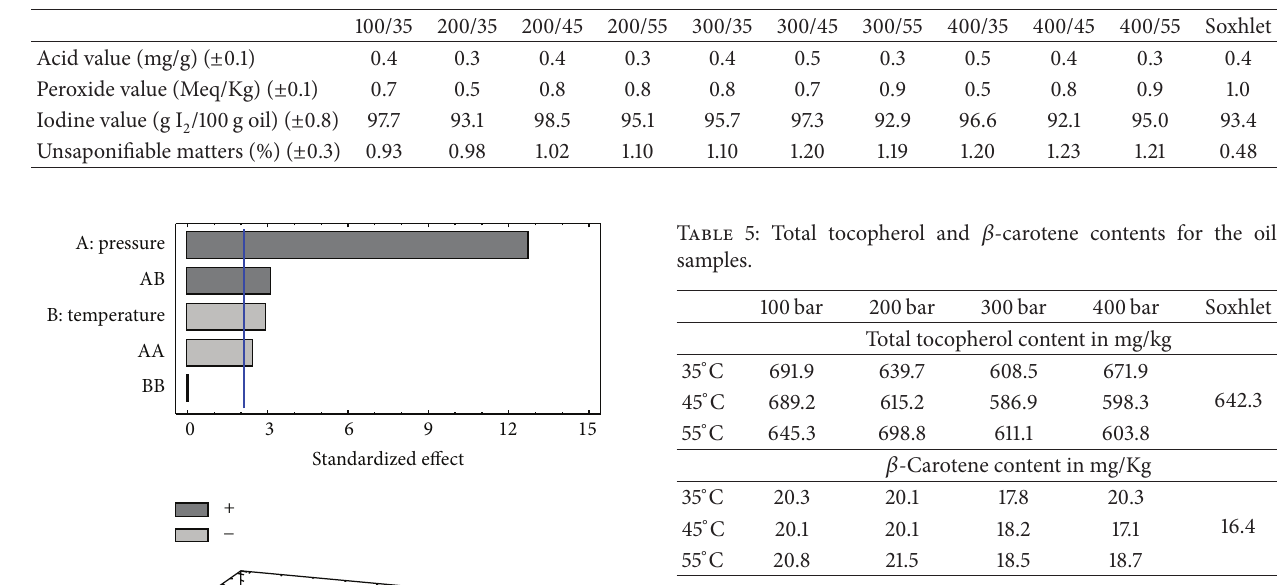
Table 3: Chemical characteristics of argan oil obtained by SFE (pressure/temperature) and Soxhlet extraction.